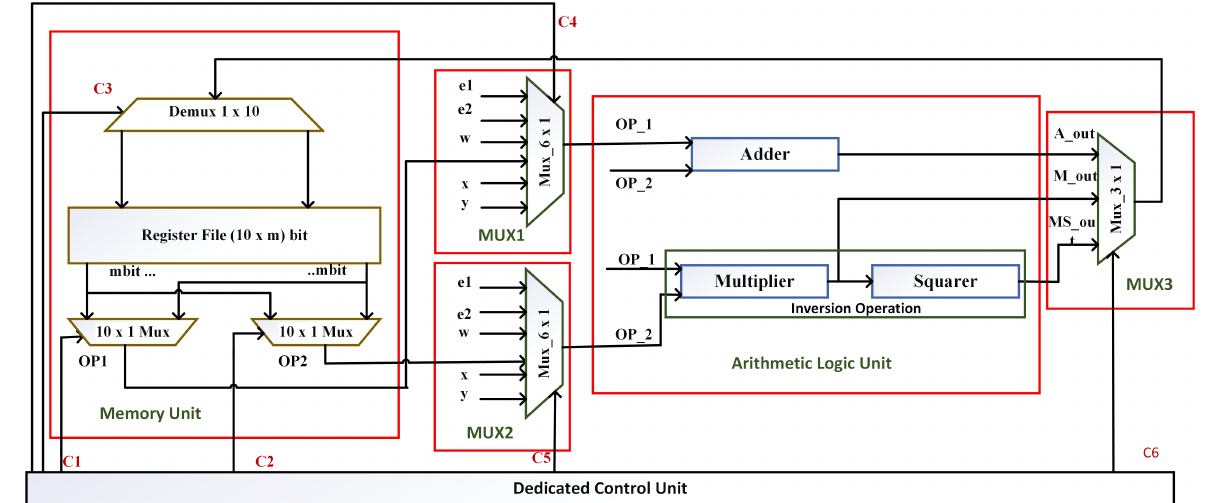
Figure 2. Proposed architecture: Detailed